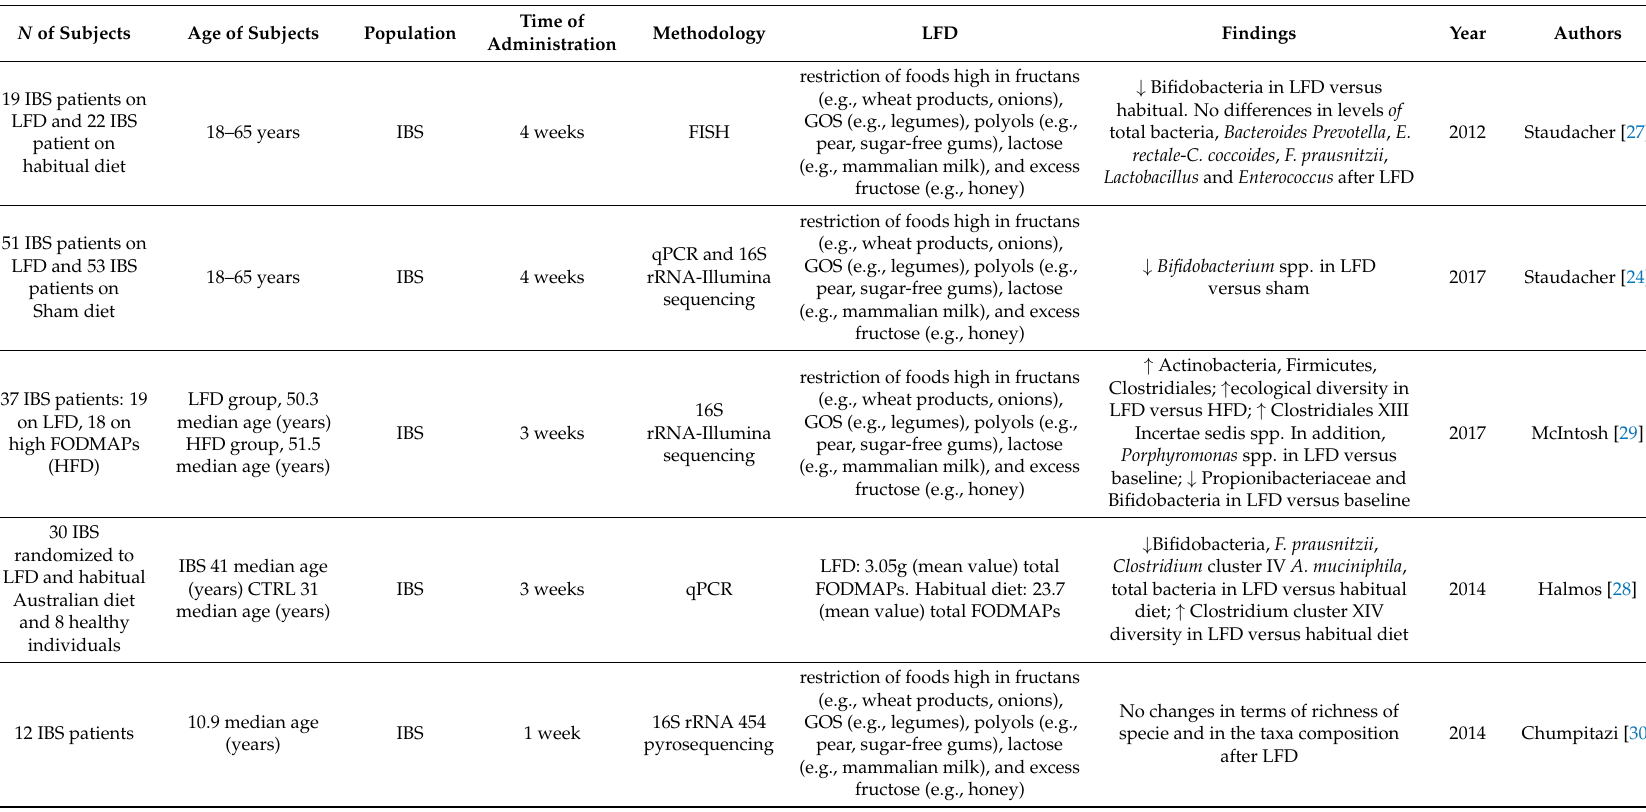
Table 1. Main findings related to the effect of low-FODMAPs diet (LFD) on gut microbiota in irritable bowel syndrome (IBS) and Non-Celiac Gluten